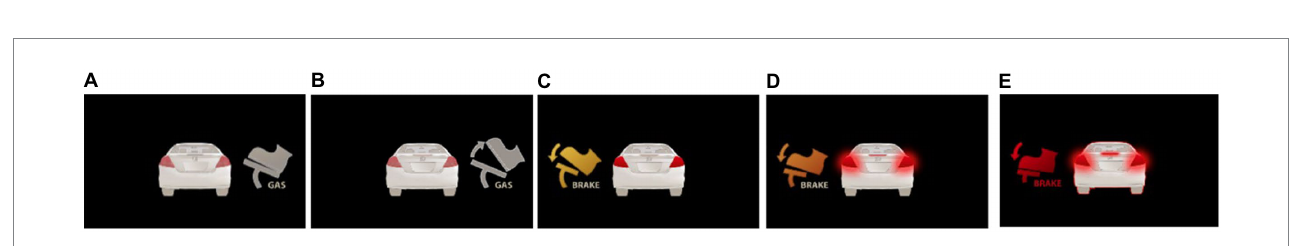
FIGURE 6 Braking information display. Icons shown when the driver has his foot on the gas pedal (A) , releases the gas pedal (B) , and applies different intensities of pressure to the brake pedal (C–E) .